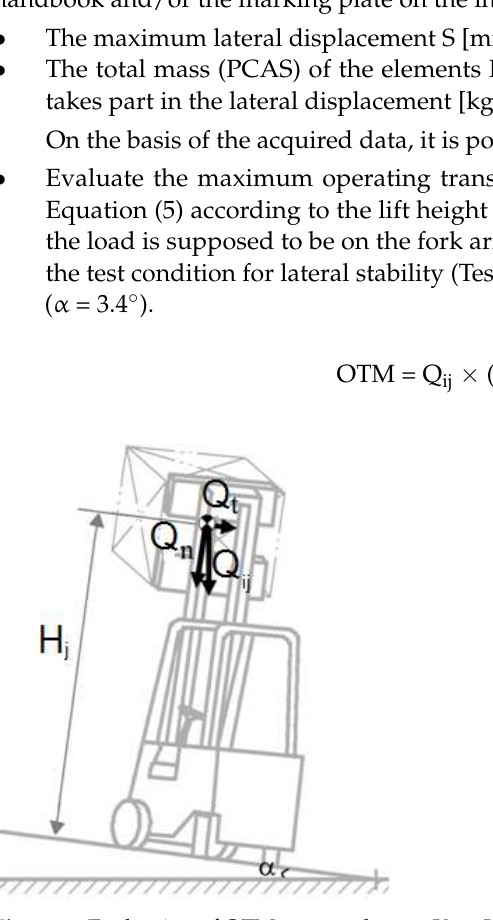
Figure 4. Evaluation of OTM: nomenclature. Key: H j —lift height; Q ij —rated capacity according to D i and H j ; Q n —rated capacity component normal to tilting platform; Q t —rated capacity component tangent to tilting platform; α — slope.